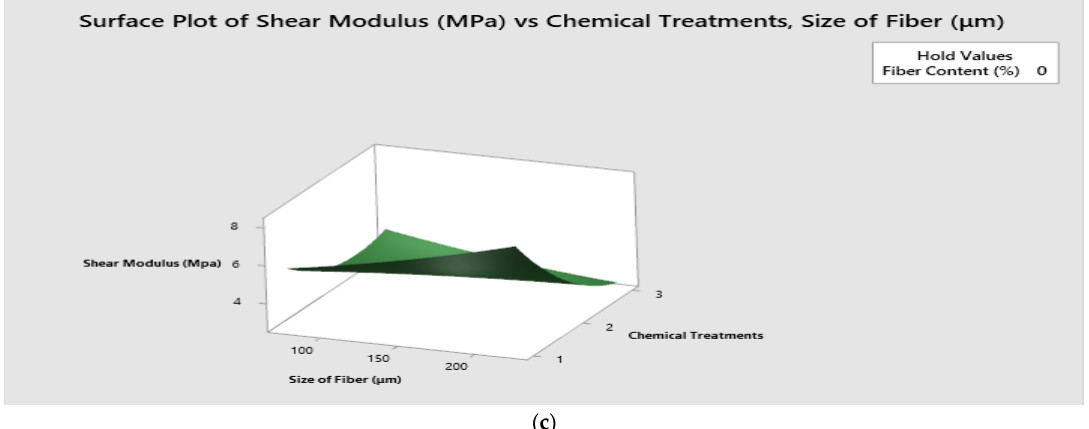
Figure 10. Surface plot for Shear modulus. ( a ) Surface plot of shear modulus vs. fiber size ( μm )/fiber content (wt.%). ( b ) Surface plot of shear modulus vs. chemical treatments/fiber content (wt.%). ( c ) Surface plot of shear modulus vs. chemical treatments/fiber size ( μm ). Figure 10a explains the surface plot of shear modulus vs. fiber size ( μm )/fiber content (wt.%). One can understand from the figure that the combination of 2% fiber content and 215 – 225 μm fiber size offers high shear modulus.